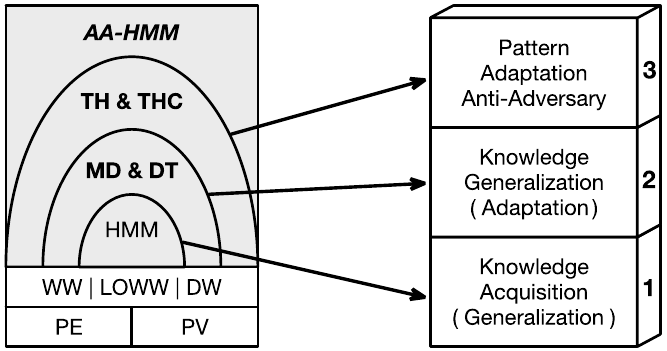
Figure 3. Anti-Adversarial Hidden Markov Model’s (AA-HHM) overview architecture.